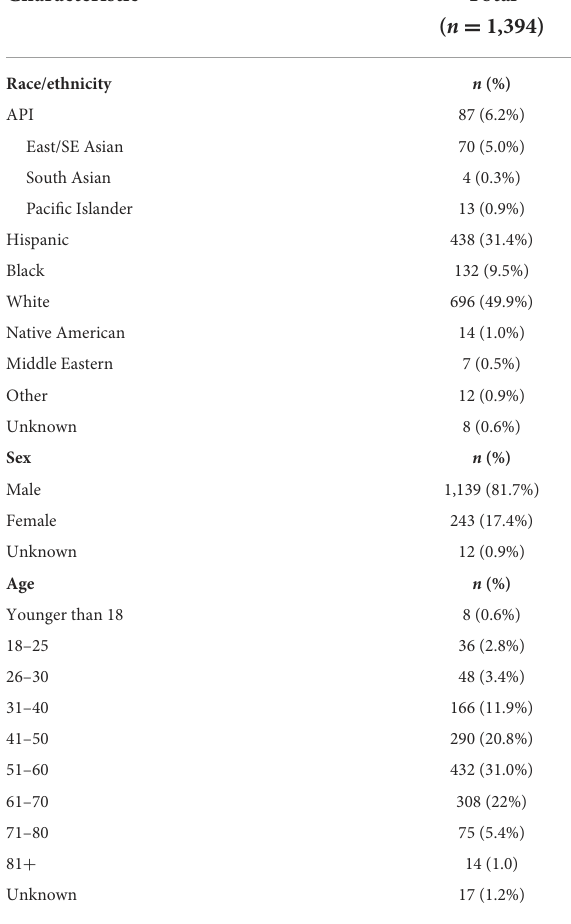
TABLE 1 Characteristics of the sample ( n = 1,394), including APIs ( n = 87) and sub-groups.